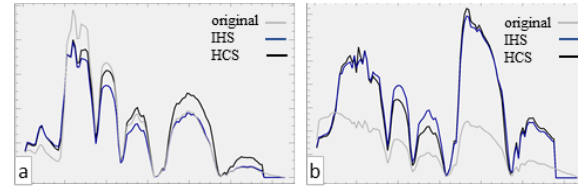
Figure 8. Quality control of fused images (IHS transform and HCS transform) using spectral profile of selected pixels of (a) vegetation area and (b) buildings